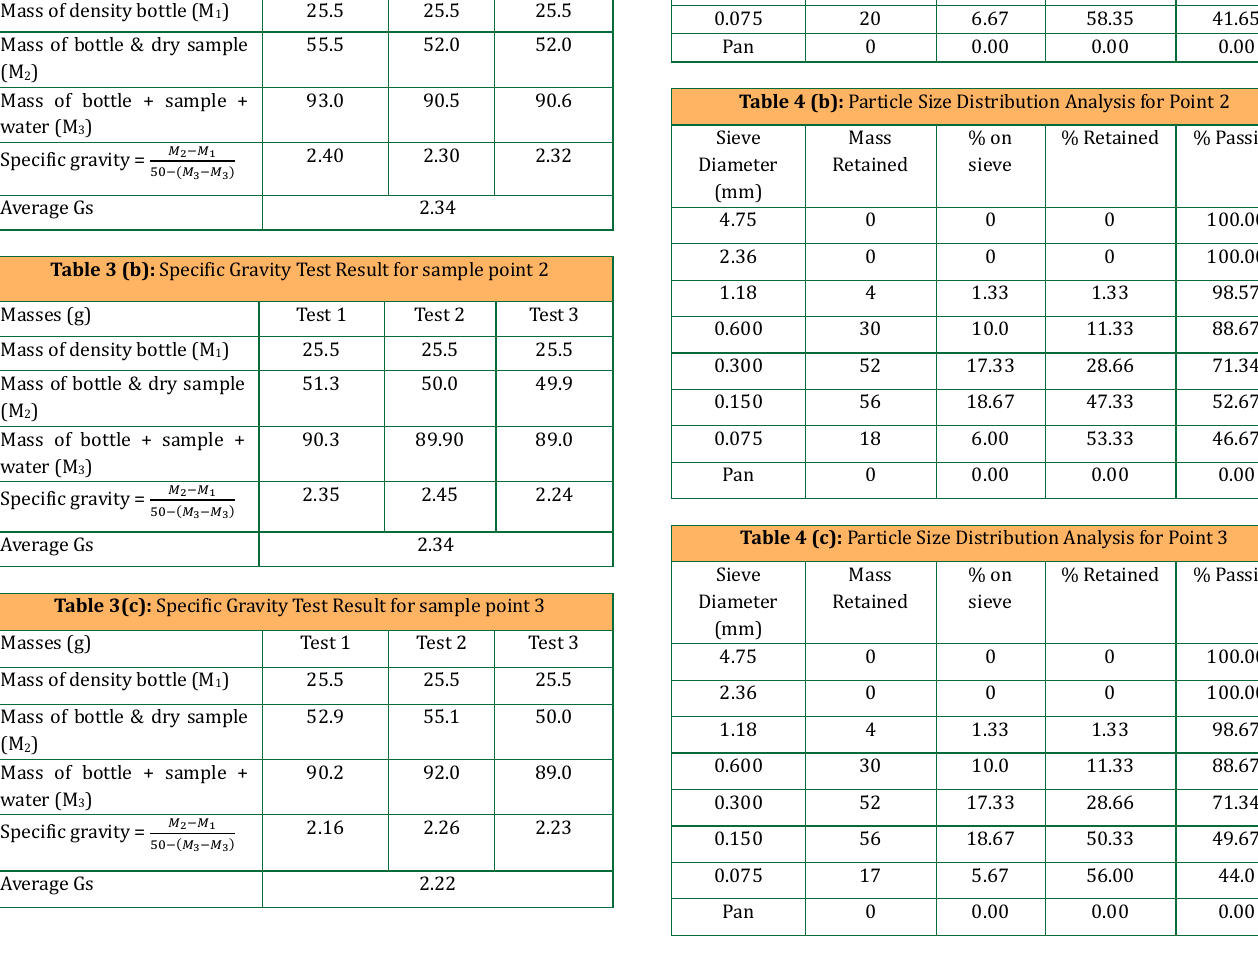
Table 3 (a): Specific Gravity Test Result for sample point 1 Masses (g)